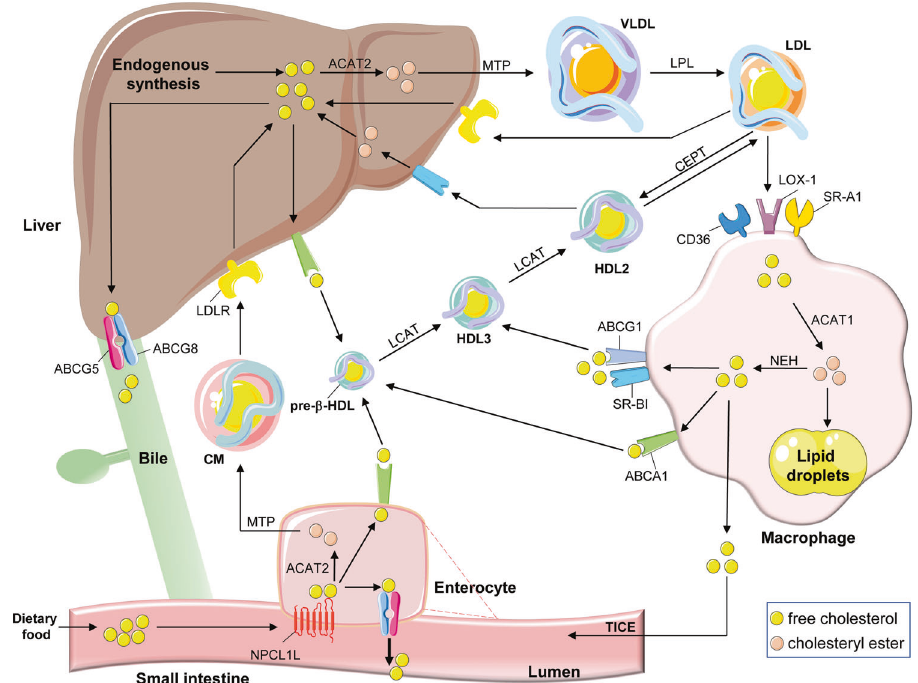
Fig. 3 Regulation of cholesterol transport. Daily food and the hepatic endogenous synthesis are the two main sources of human cholesterol, of which dietary free cholesterol (FC) uptake is mediated by Niemann-Pick C1 Like 1 (NPC1L1) protein in enterocytes. The endocytosis of cholesterol by NPC1L1 responds to the change of cellular cholesterol concentration. FC taken up by NPC1L1 in enterocytes is esteri fi ed to cholesteryl ester (CE) by acyl-CoA:cholesterol acyltransferase 2 (ACAT2), which is loaded into ApoB-48 with triglycerides (TG) mediated by microsomal triglyceride transfer protein (MTP), to form chylomicron (CM). After TG in CM is hydrolyzed and utilized, most of the remaining cholesterol will be absorbed through low-density lipoprotein receptor (LDLR) in the liver. In contrast, some unesteri fi ed cholesterol is pumped back to the intestinal lumen by ATP-binding cassette (ABC) transport proteins G5 and G8 (ABCG5/ABCG8) or synthesized into pre- β -HDL by ABCA1 and released into circulation. Cholesterol synthesized endogenously in the liver is converted into VLDL with TG, ApoB-100, and most of VLDL is then converted into LDL, which is the main carrier for transporting endogenous cholesterol. LDL is taken up by scavenger receptors in macrophages, where expression of CD36, scavenger receptor A1 (SR-A1), and LDL receptor 1 (LOX1) is increased in atherosclerosis, further promoting cholesterol accumulation. LDL is endocytosed into macrophages and hydrolyzed by lipase (LAL) to produce FC. Excess FC is esteri fi ed by ACAT1 and stored as lipid droplets, and the excess accumulation of CE in macrophages can contribute to formation of foam cells. To mediate cholesterol ef fl ux, macrophages hydrolyze CE into FC by the neutral cholesteryl ester hydrolase (NEH). Macrophage-mediated cholesterol ef fl ux includes simple diffusion, SR-BI-facilitated diffusion, and ABCA1/ABCG1-mediated ef fl ux. Among them, simple diffusion dominates cholesterol ef fl ux in normal macrophages, regulated by cholesterol concentrations. In cholesterol overloaded macrophages, ABCA1 and ABCG1 are critical for cholesterol ef fl ux. ABCA1 is able to bind to ApoA-I to mediate the production of pre- β -HDL, lecithin cholesterol acyltransferase (LCAT) further matures pre- β -HDL particles into HDL3, while ABCG1 and SR-BI mediate cholesterol fl ow directly to HDL3. HDL3 is further esteri fi ed by LCAT to produce HDL2, in which CE is eventually taken up by SR-BI in the liver and converted to FC.